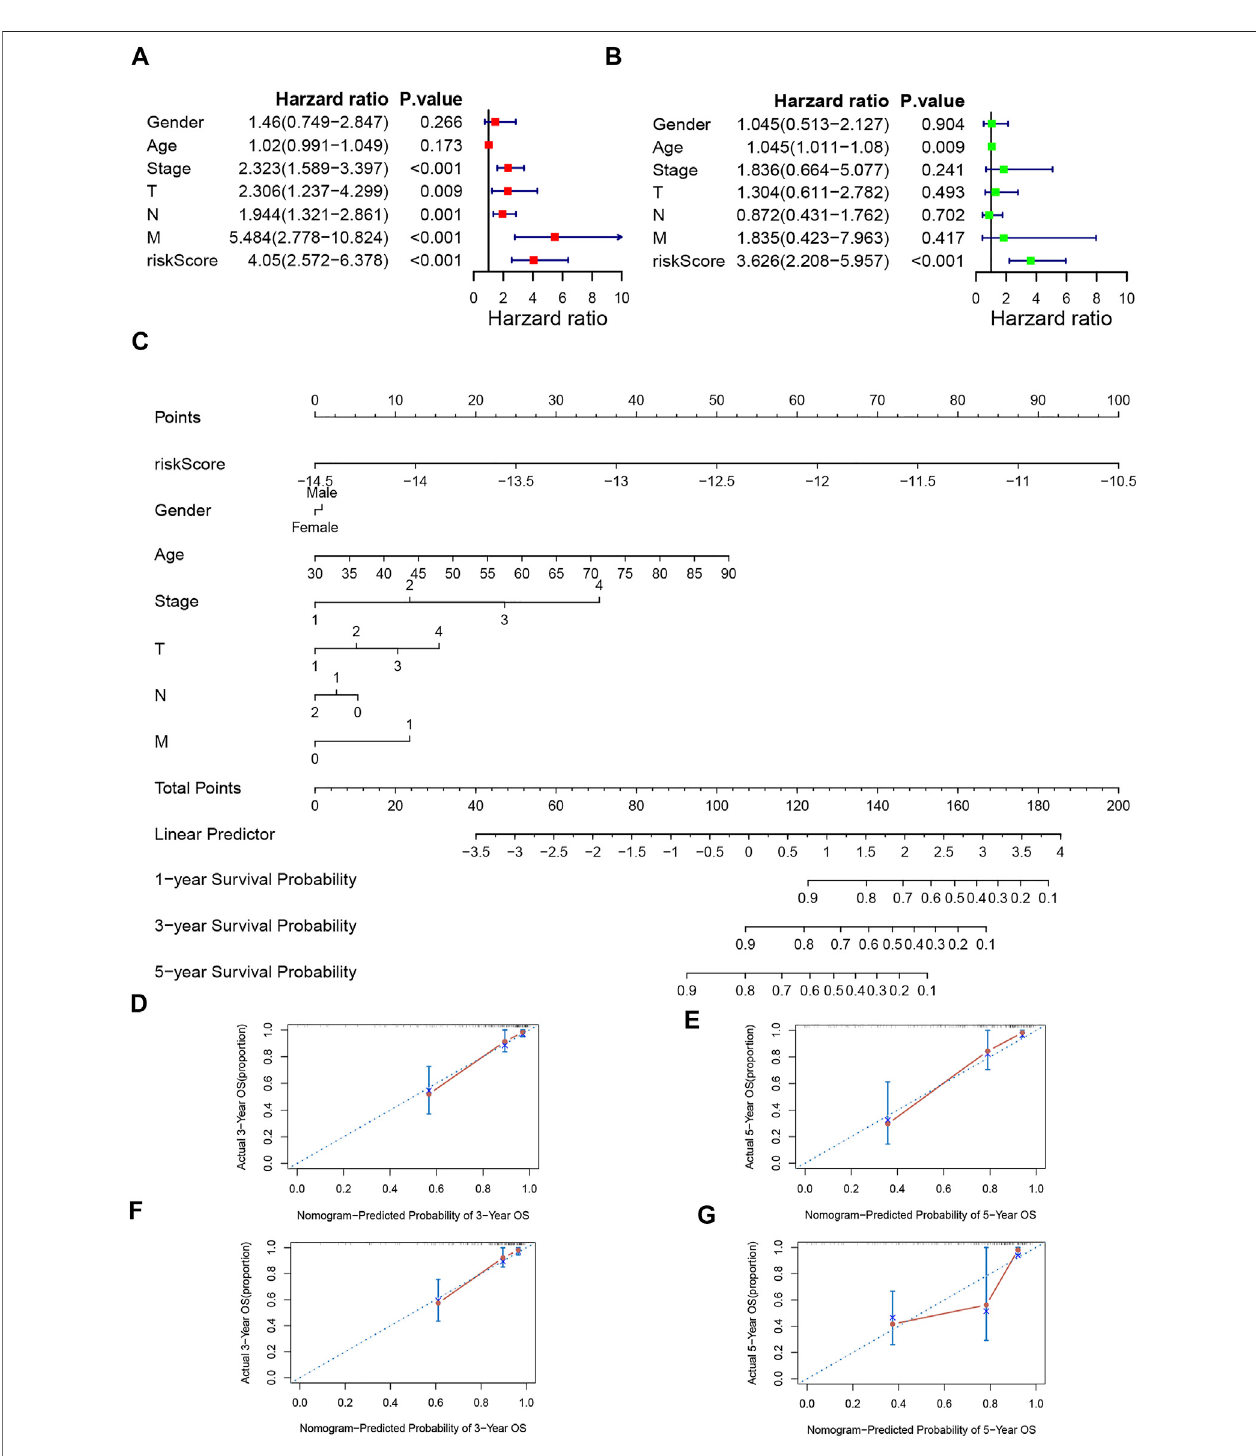
FIGURE 6 | Independence veridiction of the risk model and construction and calibration of nomogram. (A). Univariate independent prognostic analysis in the training group; (B). Multivariate independent prognostic analysis in the training group; (C). A nomogram integrating clinical factors and risk score; (D,E). Calibrations of the nomogram at 3-years and 5-years survival in the training set; (F,G). Calibrations of the nomogram at 3-years and 5-years survival in the validation set.